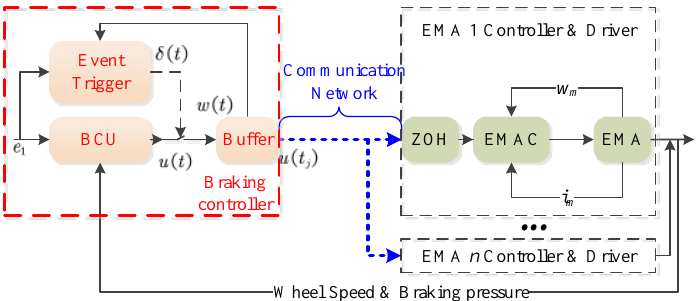
Figure 5. Detailed schematic of the event-triggering mechanism of the all-electric braking system.